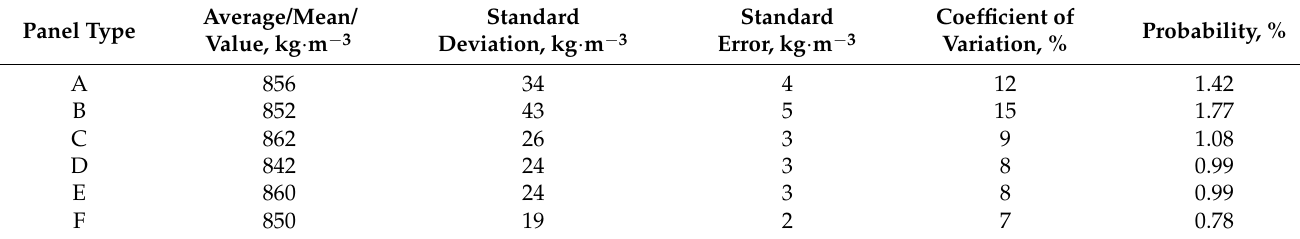
Table 2. Density of fiberboard panels bonded with HL and PF resin.